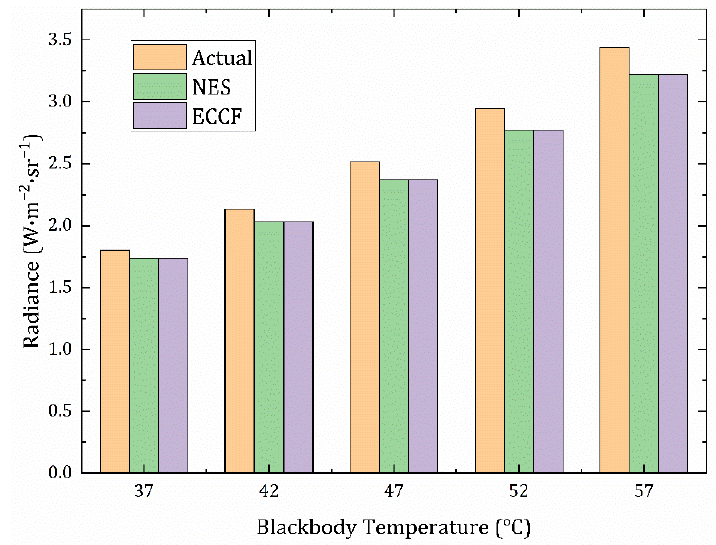
Figure 10. Comparison of the inversion radiance of the two methods with the actual radiance of the target.